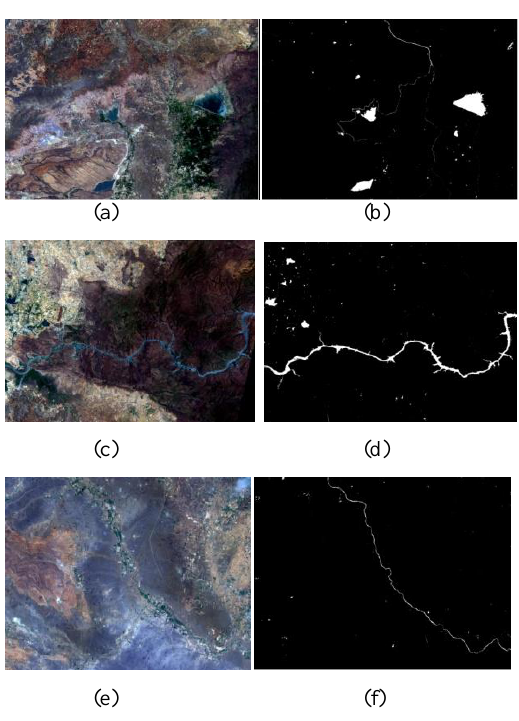
Figure 13: (a),(c),(e) are sub scenes of Scene-2 (b), (d),